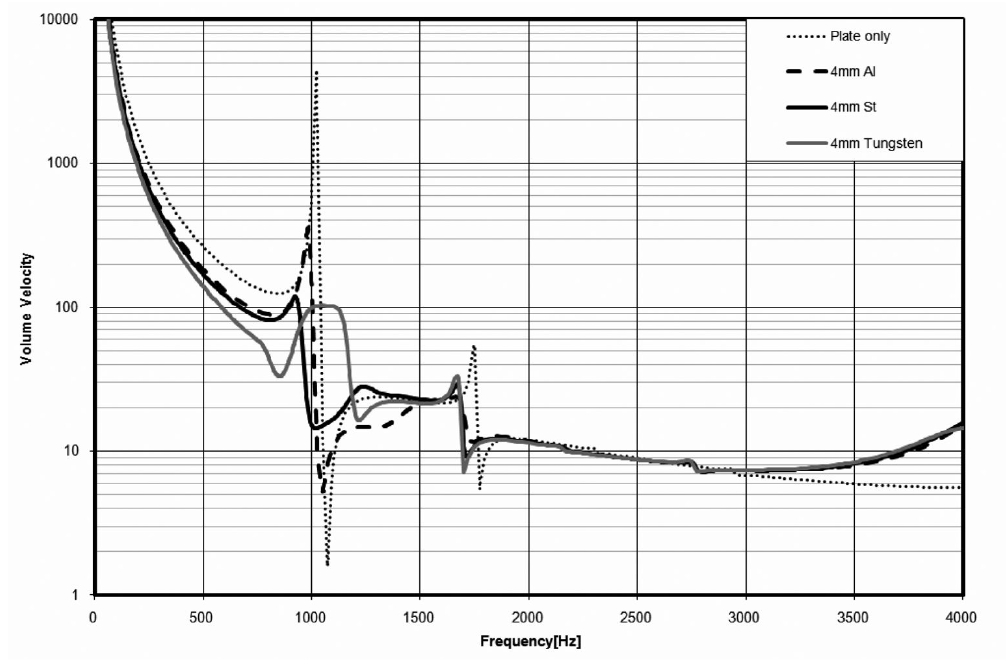
Fig. 57. Frequency response curves for four cases of free-free plate Plate only (dotted), Plate with added Steel ball EIDL (solid black), Plate with added Aluminium ball EIDL (dashed), Plate with added Tungsten ball EIDL (solid